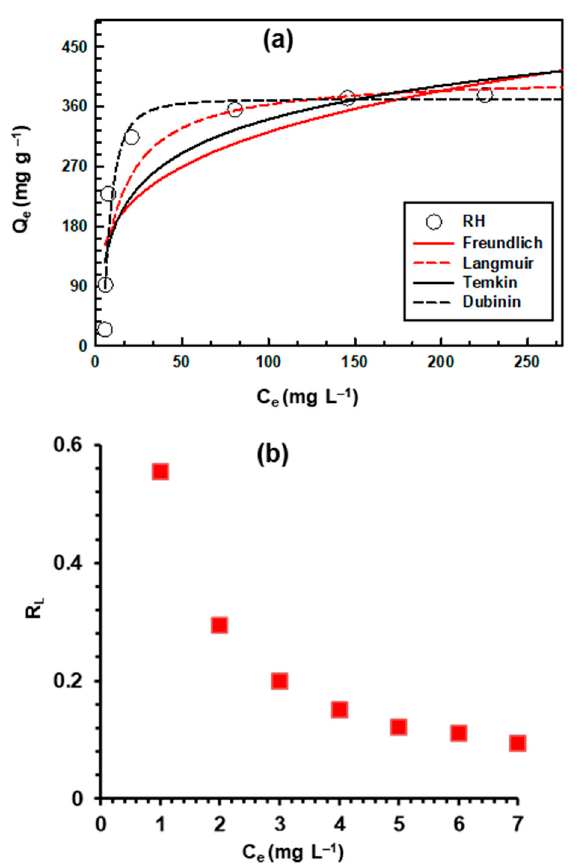
Figure 4. Isotherm models ( a ) and separation factor ( b ) for Cr(VI) adsorption onto rice husk. C e , equilibrium concentration; C 0 , initial concentration. Table 2. Parameters of isotherm modeling for Cr(VI) elimination by rice husk.